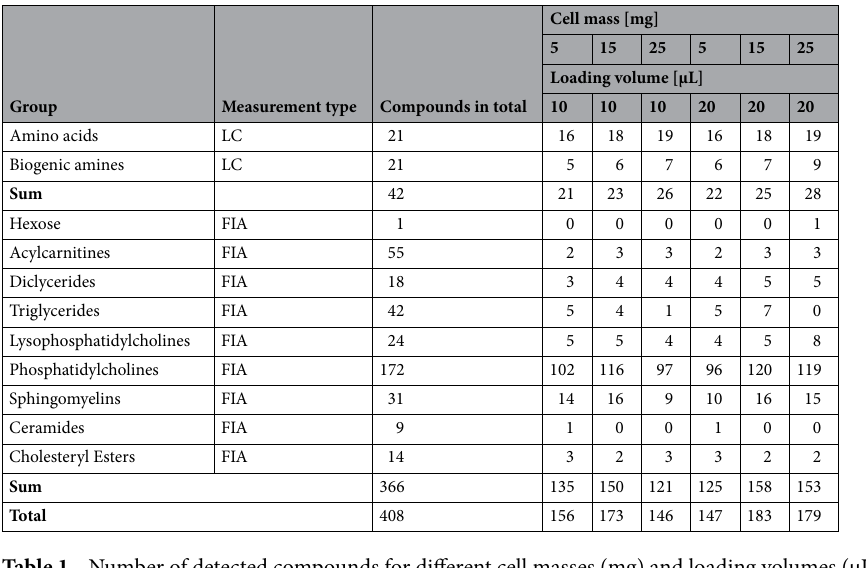
Table 1. Number of detected compounds for different cell masses (mg) and loading volumes (µL) for both liquid chromatography (LC) and flow injection analysis (FIA) mass spectrometry using the Biocrates p400 HR kit. Five replicates were measured in each condition; outliers were removed from the final analysis as described in the materials and methods. BR: Biological replicates. A strict noise threshold filter was applied to data such that in some cases, compounds were detected but filtered out before these results were compiled. Significant values are in bold.